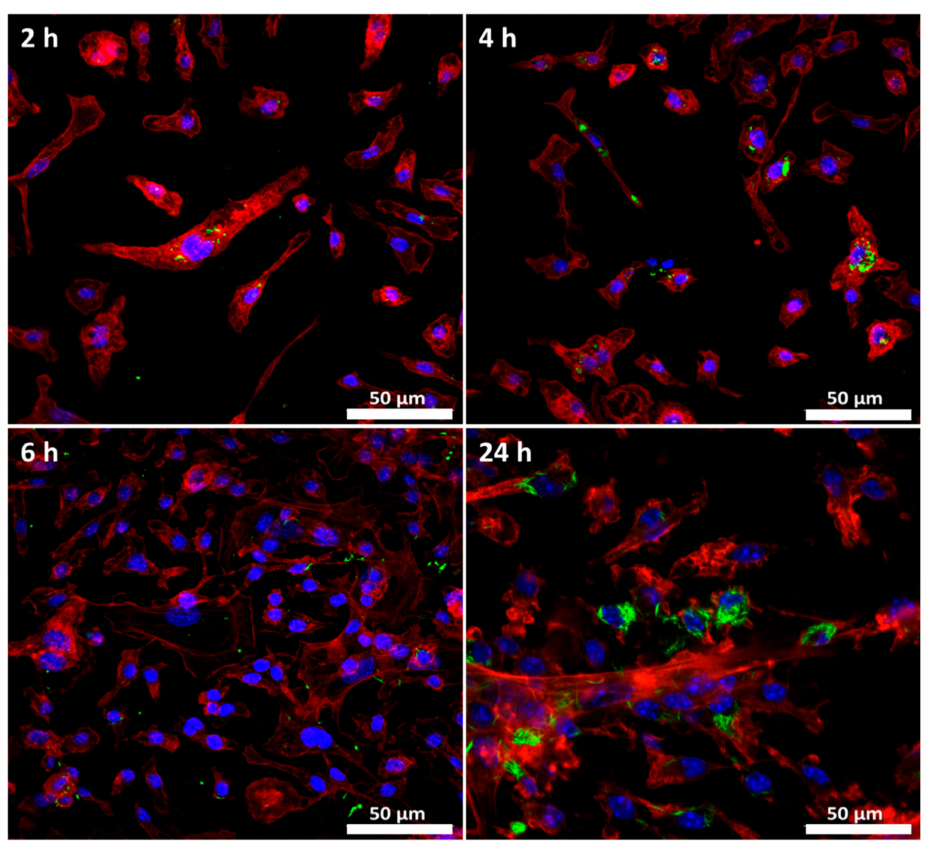
Figure 8. Cellular uptake of BCNC by phagocytic cells. FM images of macrophages exposed to 0.001 mg/mL BCNC for 2, 4, 6 and 24 h. DAPI (blue), Pha-red (red) and GFP–CBM (green) were used for nuclei, actin cytoskeleton and BCNC visualization, respectively. Scale bar: 50 µ